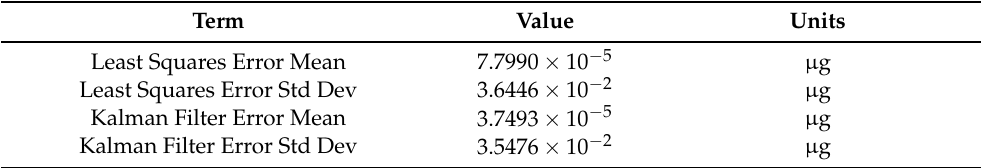
Figure 4. Results for the forcing acceleration estimate error from the Kalman filter. Estimate error is plotted in blue with the associated 3 σ bounds in red. This is accompanied by the true bias time history in cyan. Table 3. Key performance statistics from 10,000 Monte Carlo trials of both acceleration estimation